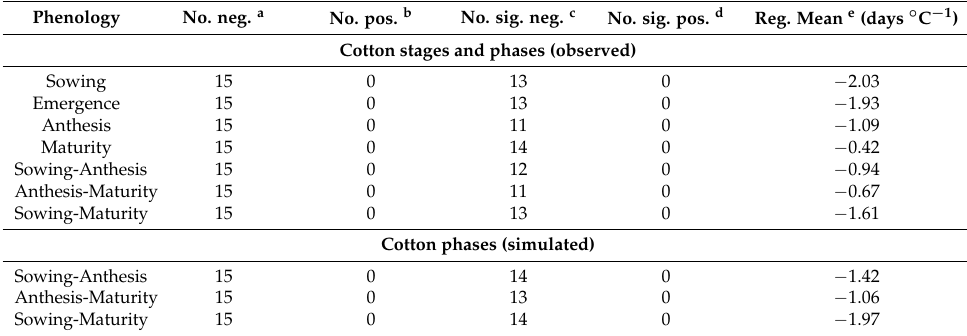
Table 2. Summary of observed and simulated phenology response to temperature for cotton in Punjab, Pakistan, for 1980–2015.